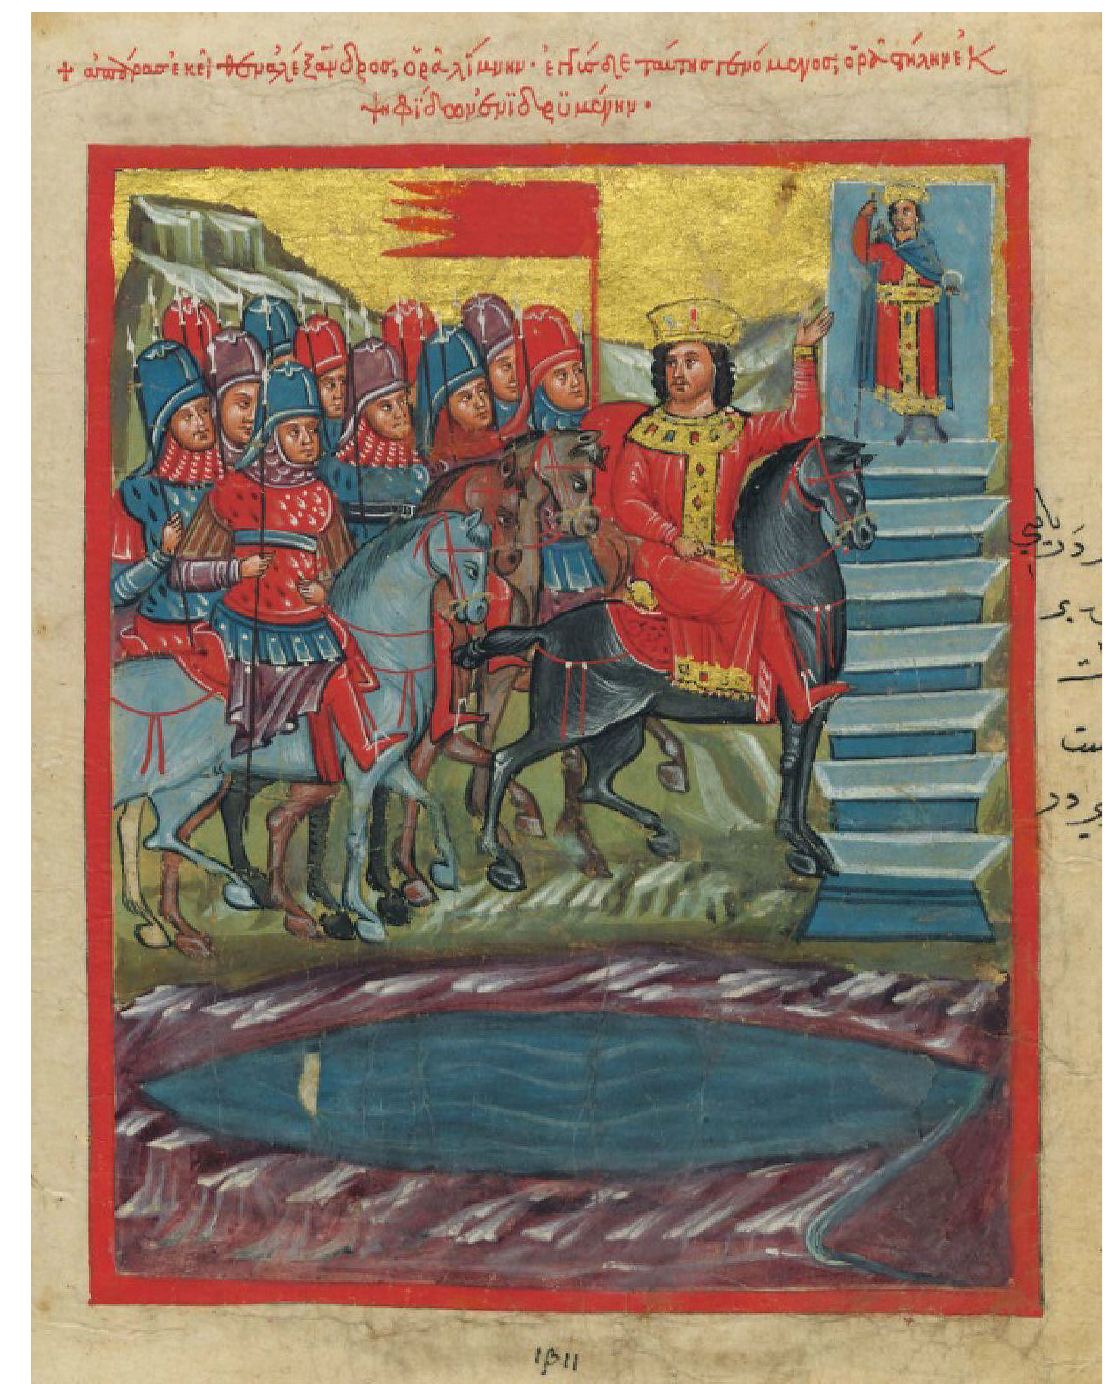
Figure 12. Venice. Istituto Ellenico di Studi Bizantini e Postbizantini cod. 5, fol. 103r (detail). Alexander and his army reach the image of Sesonchosis. Photo: ©Istituto Ellenico di Studi Bizantini e Postbizantini, Venice, all rights